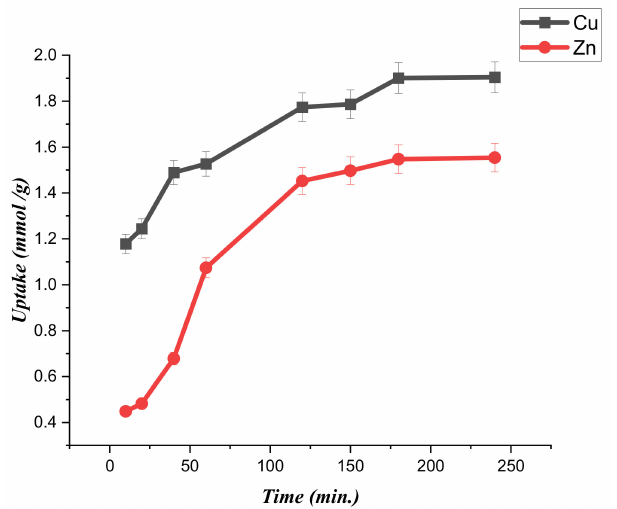
Figure 7. Time effect on the uptake capacity of (CTS-CAA) sorbent towards both copper and zinc ions. It was observed that the modified chitosan presents an efficient adsorption capacity (larger than 60% of the uptake at saturation) after 40 and 60 min for copper and zinc ions, respectively. The saturation of the adsorption sites of the (CTS-CAA) sample gen- erated uptake values of ca. 1.9 ± 0.035 and 1.5 ± 0.04 mmol/g for Cu (II) and Zn (II) ions,